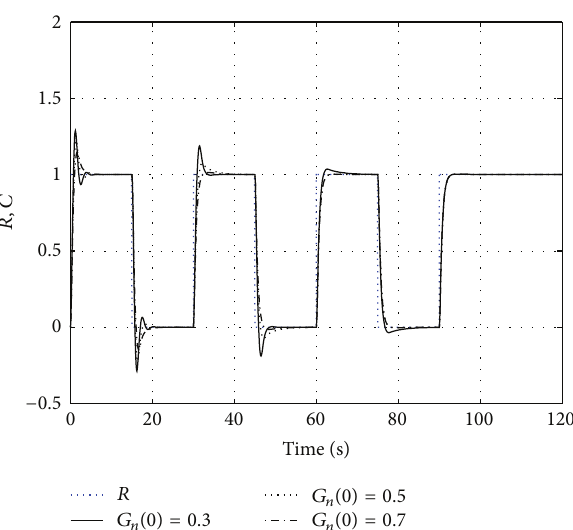
Figure 7: Online automatic tuning process of the illustrating example using different initial 𝐺 𝑛 (0)